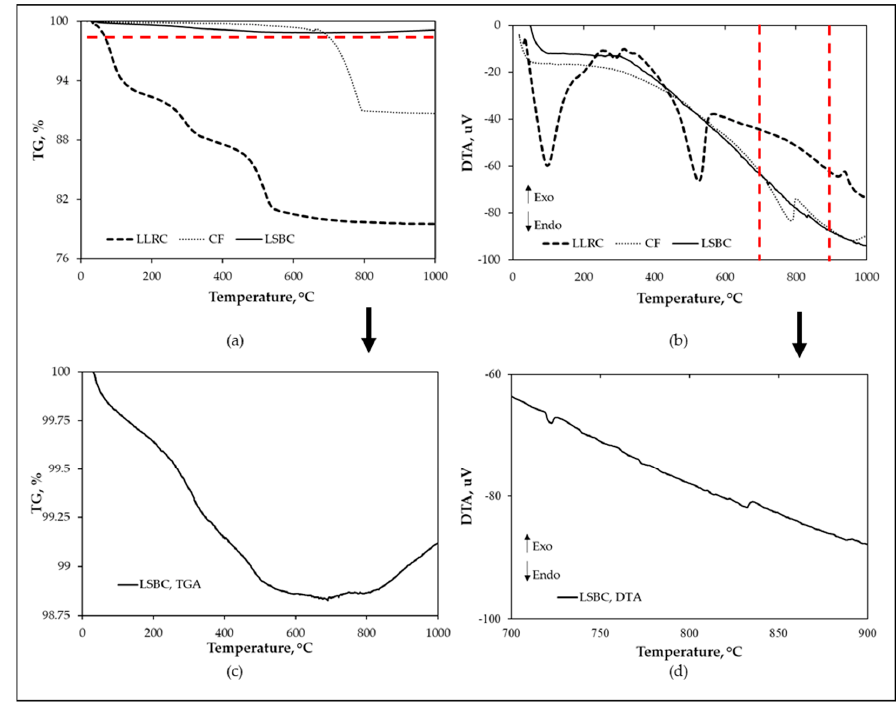
Figure 4. TGA-DTA of raw materials: ( a ) TGA; ( b ) DTA; ( c ) magnified portion of TG curve of LSBC; and ( d ) magnified portion of DTA curve of LSBC at 700–900 °C.